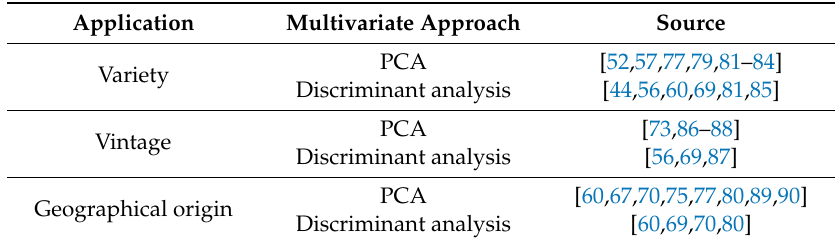
Table 1. Examples of the use of polyphenol profiles for wine